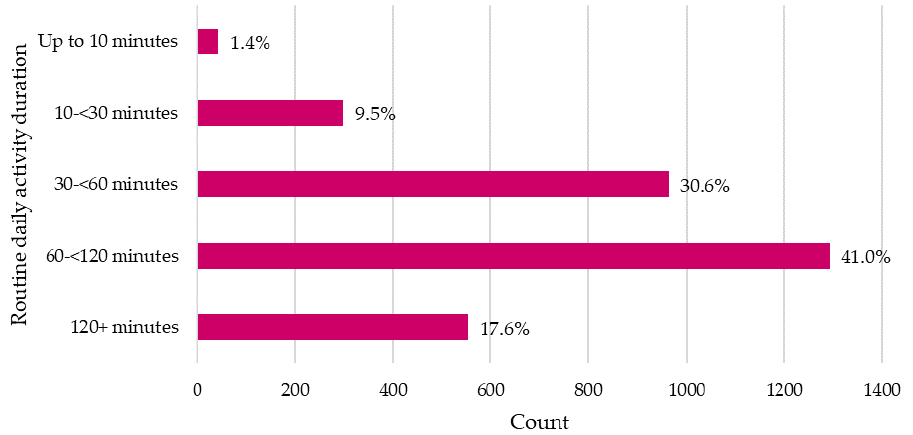
Figure 1. Distribution of daily activity duration for dogs reported by an owner survey.